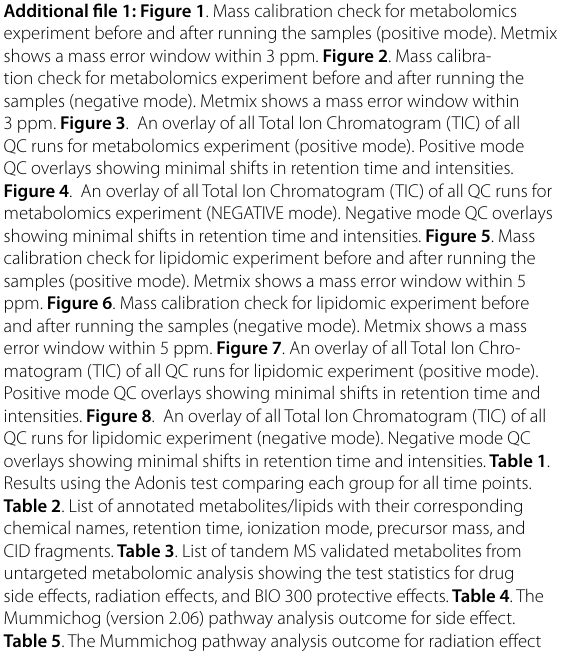
Table 2 . List of annotated metabolites/lipids with their corresponding chemical names, retention time, ionization mode, precursor mass, and CID fragments. Table 3 . List of tandem MS validated metabolites from untargeted metabolomic analysis showing the test statistics for drug side effects, radiation effects, and BIO 300 protective effects. Table 4 . The Mummichog (version 2.06) pathway analysis outcome for side effect. Table 5 . The Mummichog pathway analysis outcome for radiation